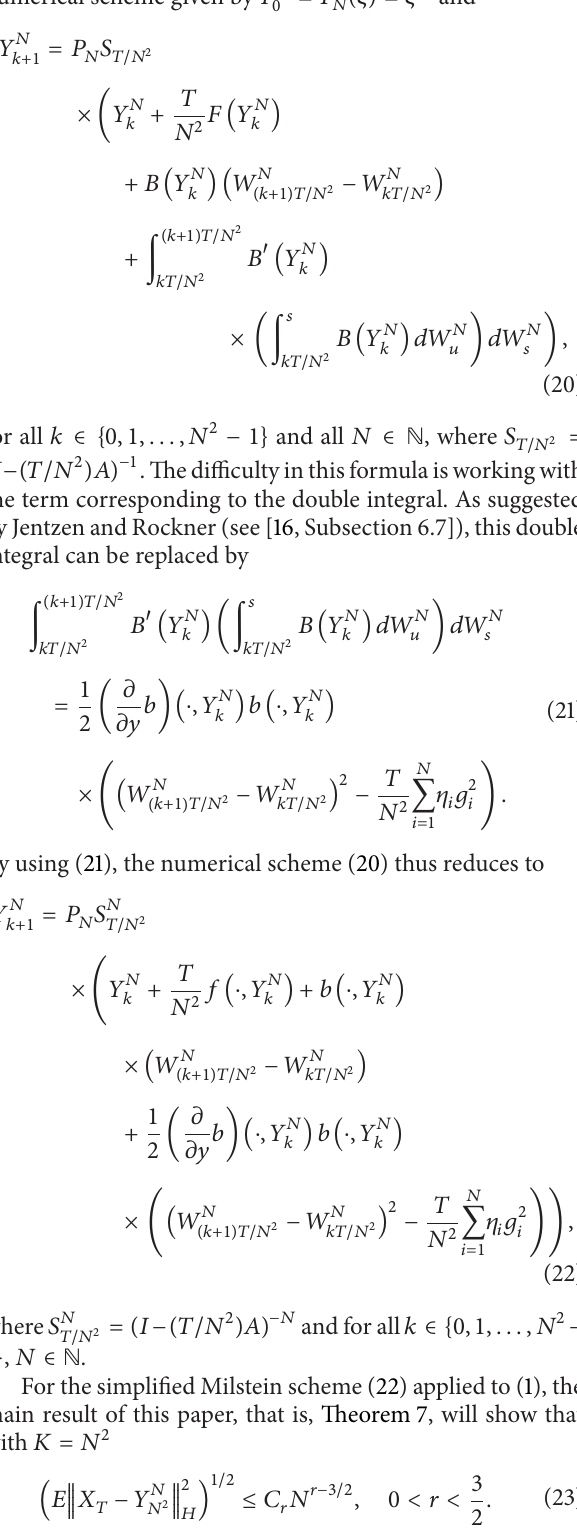
Table 1: Runtime (seconds) for one path simulation using